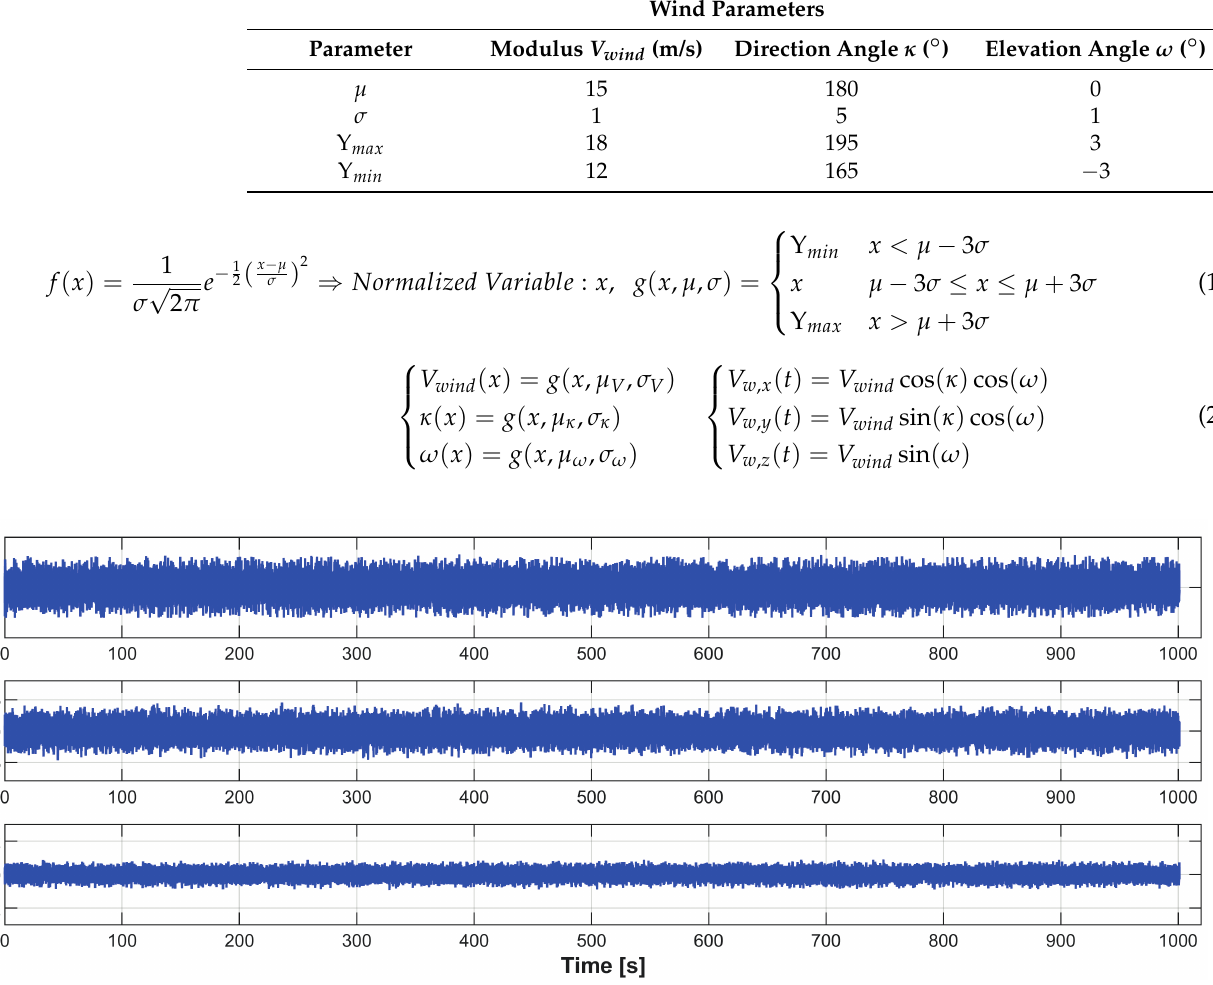
Figure A1. Wind velocity in each Cartesian